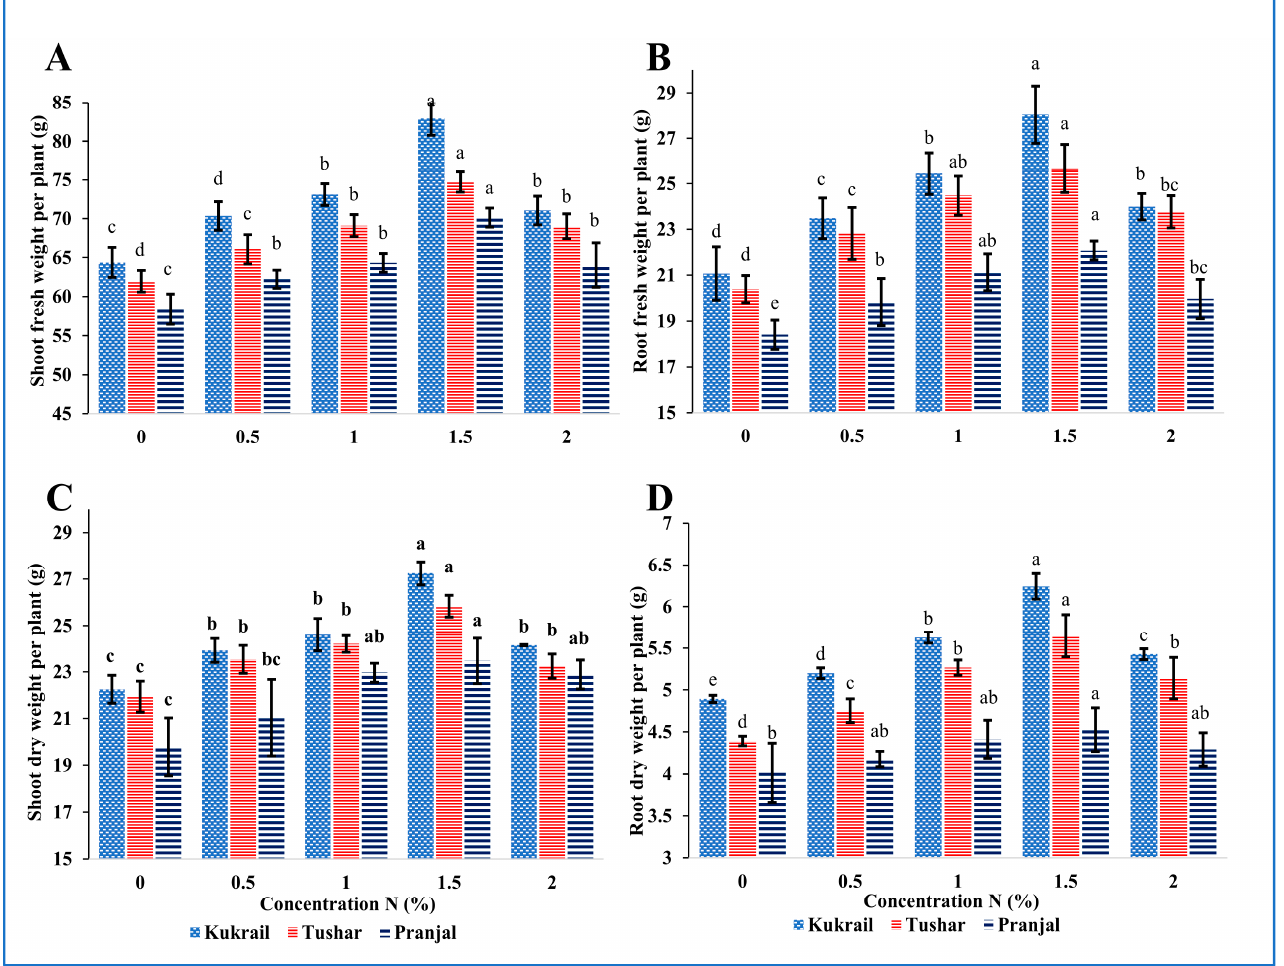
Figure 2. Effect of N on three cultivars: ( A ) Shoot fresh weight per plant, ( B ) Root fresh weight per plant, ( C ) Shoot dry weight per plant, ( D ) Root dry weight per plant of the three peppermint cultivars. Data represent the mean and bars represent the standard error (SE) of four replicates ( n = 4) of each cultivar. The letters over bars represent significance at p ≤ 0.05 by Duncan’s Multiple Range Test (DMRT).